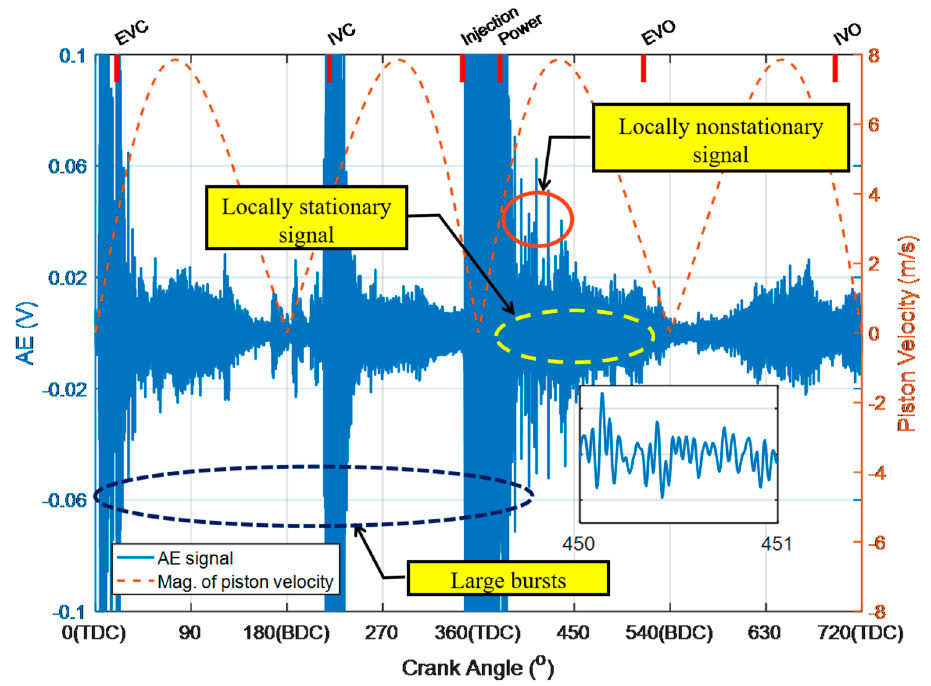
Figure 4. Acoustic emission (AE) raw signals and piston speed in a working cycle at 1200 rpm under 10 Nm.